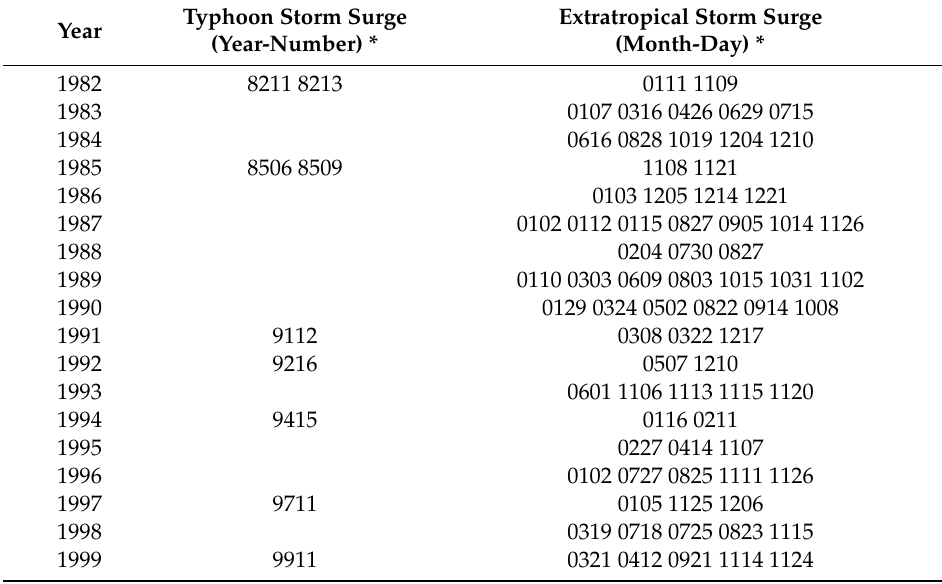
Table 2. The 166 selected storm surge cases in Weifang during